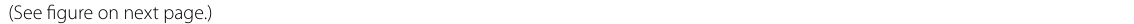
figure on next Fig. 2 Cellular effects of particles on Caco-2 (left), HepG2 (middle) and HepaRG cells (right). A MTT Assay of increasing concentrations of particles after 24 h incubation time. 0.01% Triton X-100 was used as positive control. B Cellular impedance measurements using xCELLigence ® system. Cell indices normalized to cell culture medium are shown over a time of 72 h. 50 μg/mL ZnO nanoparticles served as positive control. Data are presented as means standard deviation. The significance was calculated by performing one-way ANOVA Dunnett’s test (* ± *** p 0.001, n = ≤ =